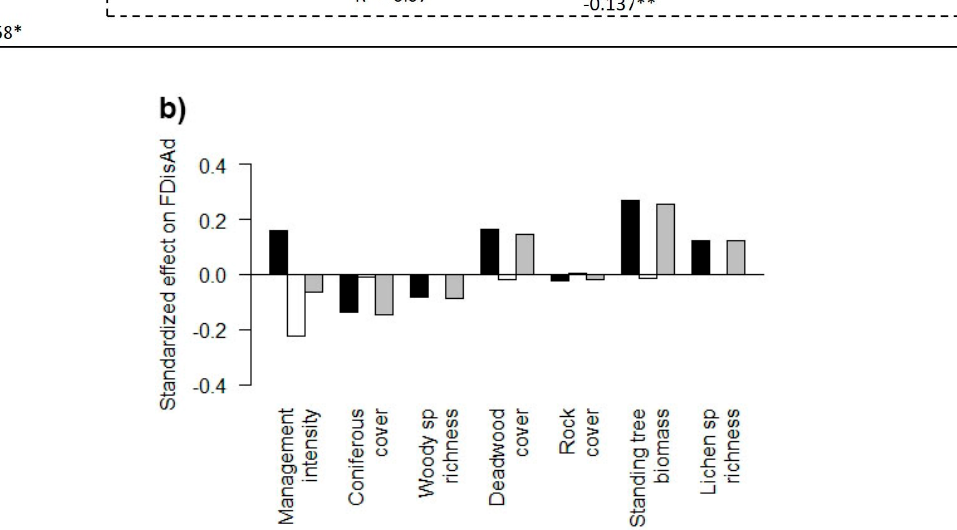
Figure 4. Effects of forest management and environmental variables on the functional diversity index based on adaptation-related traits (FDisAd). ( a ) Structural equation model depicting the direct and indirect effects of forest management and conifer cover (orange boxes) on environmental variables (blue boxes) and lichen biodiversity (green boxes). Functional diversity was calculated for adaptation-related traits (FDisAd). Single-headed arrows indicate a direct effect of a given variable on another. Double-headed arrows indicate a mutual dependency between two variables. Numbers adjacent to the arrows show standardized path coefficients; the widths of the lines are proportional to the size of the path coefficients. Solid lines indicate positive and dashed lines negative relationships. Asterisks next to the path coefficients indicate p -values: ***, p < 0.001; **, p < 0.01; *, p < 0.05; no asterisk, p ≥ 0.05 (n.s.). The dashed arrows show co-variances between factors. R 2 values denote the proportion of variance explained for the endogenous variables. ( b ) Direct effects (black bars), indirect effects (white bars) and standardized total effects (direct × indirect effect; grey bars) of all factors on FDisAd, derived from the structural equation models.